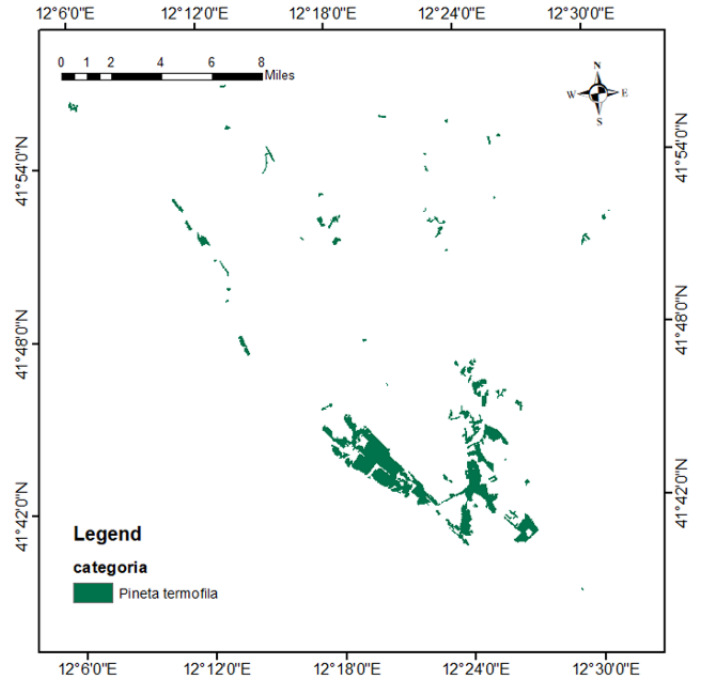
Figure 2. Pine trees (genus Pinus)—reference data.